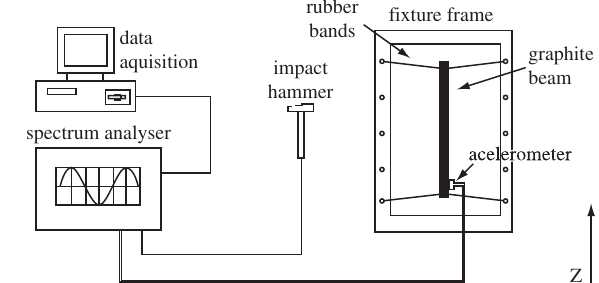
Figure 3. General view of the test